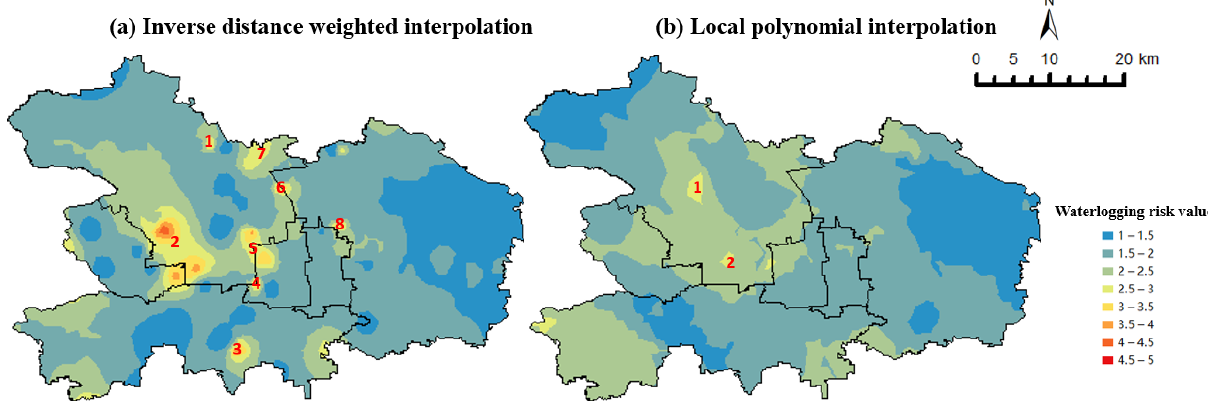
Figure 5. Waterlogging risk assessment map by inverse distance weighted method and local polynomial method.